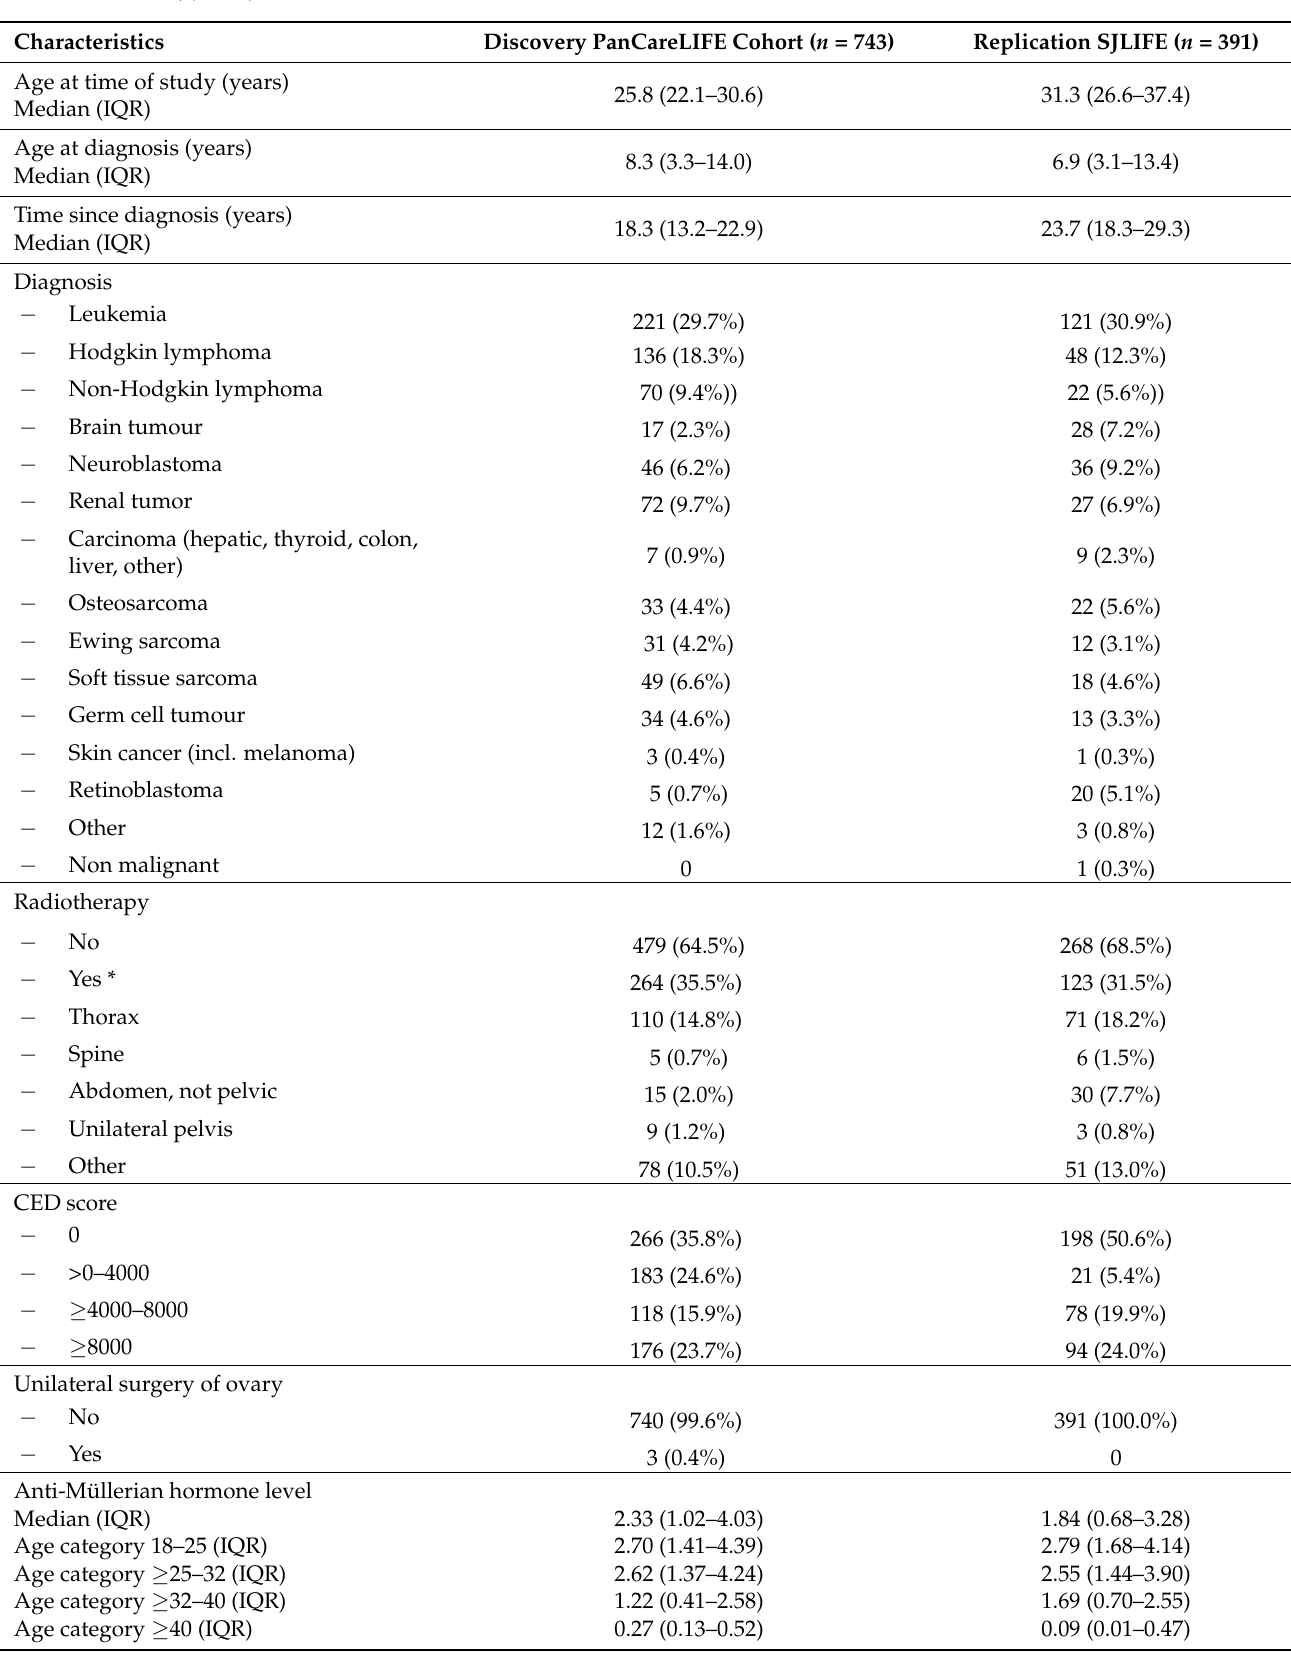
Table 1. Characteristics of participating CCSs of the discovery PanCareLIFE cohort and CCSs of the replication St. Jude LIFE cohort